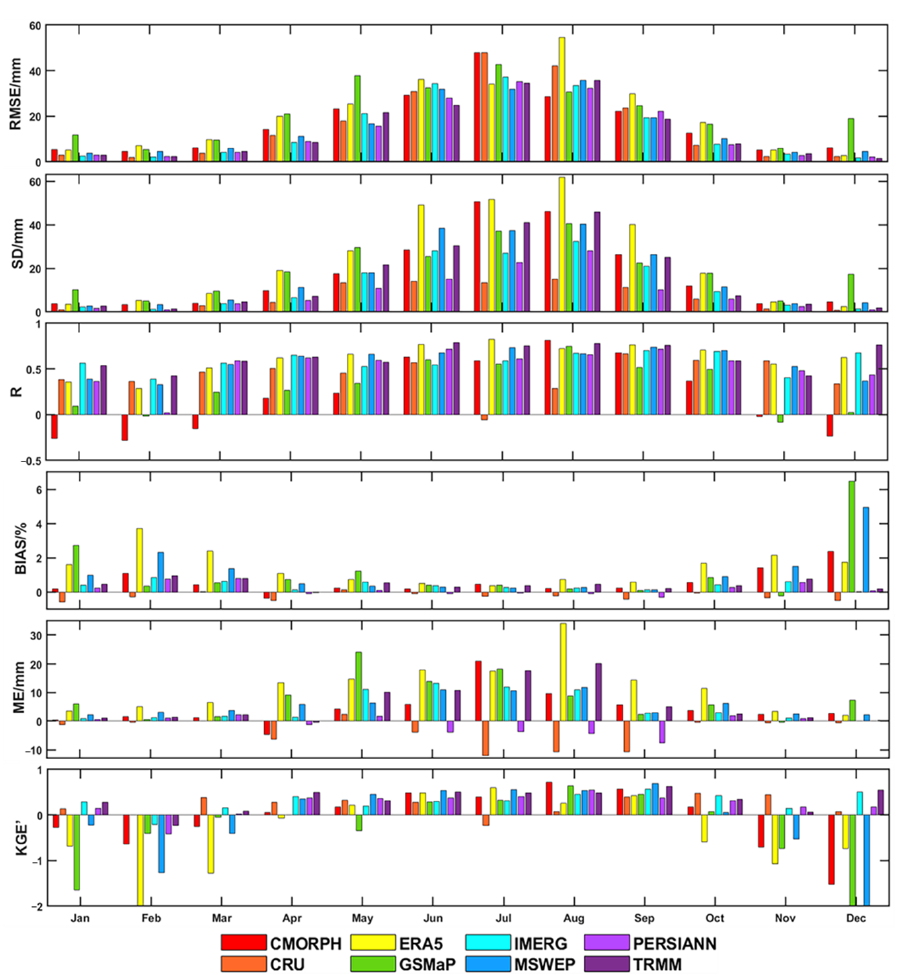
Figure 10. Bar plots of 6 indices of monthly precipitation estimates from each product between observations at stations over the HRB in different months during 2016–2019.